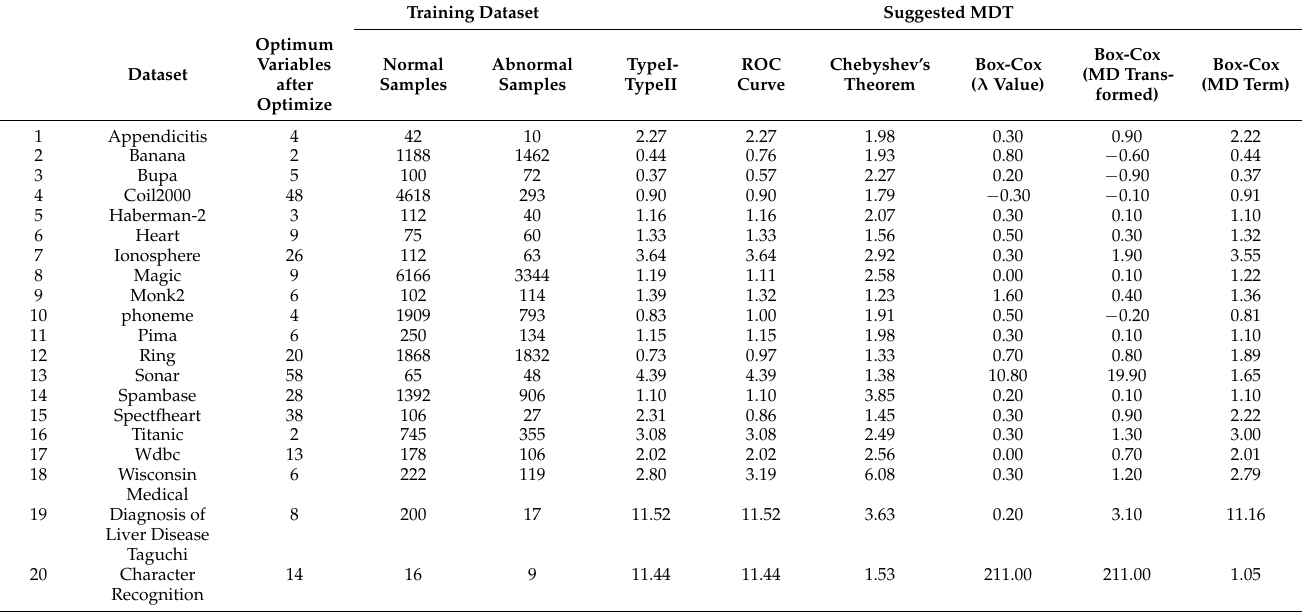
Table 8. Optimum Threshold (MD T )